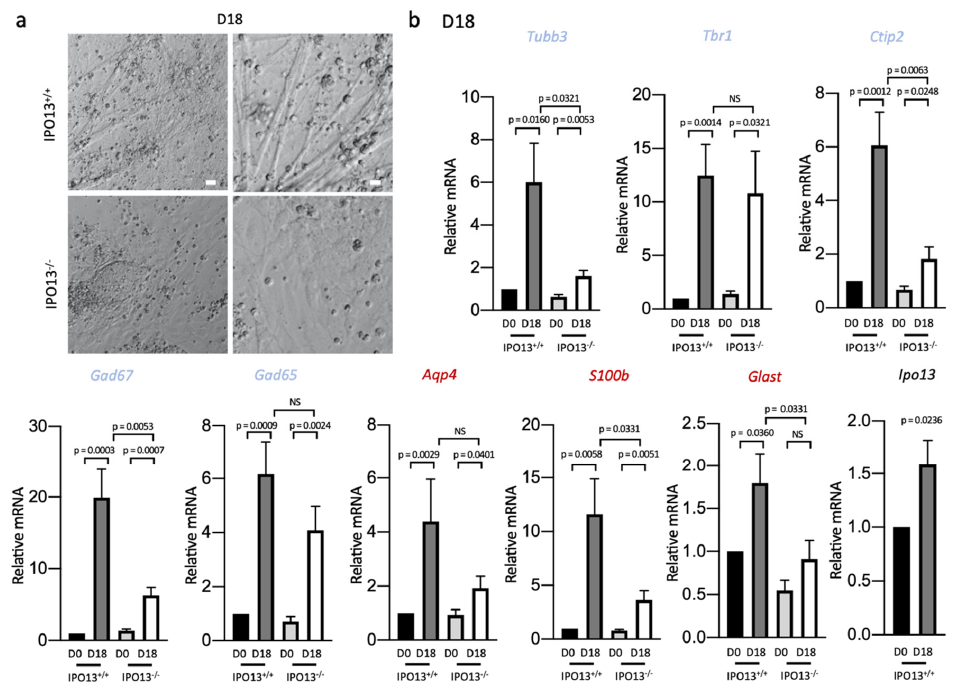
Figure 5. Absence of IPO13 impairs differentiation of progenitor cells to neurons at D18. IPO13 +/+ and IPO13 − / − D10 cells were induced to differentiate toward the dorsal forebrain neuron fate (see Figure 4a). ( a ). Representative phase-contrast images of IPO13 +/+ and IPO13 − / − cells imaged at differentiation D18 using phase contrast. Scale bar = 50 µm ( b ). RNA was extracted from IPO13 +/+ and IPO13 − / − cells at D10 and D18. Transcript levels were assessed as in Figure 4d and normalised to the expression of housekeeping genes Sdha , Tbp , and 18s . Gene names in blue and red denote neuron and astrocyte markers, respectively. Data were relativised to IPO13 +/+ D10 expression values. Results represent the mean ± SEM ( n = 4, where each cDNA sample was measured in duplicate). p values as per Figure